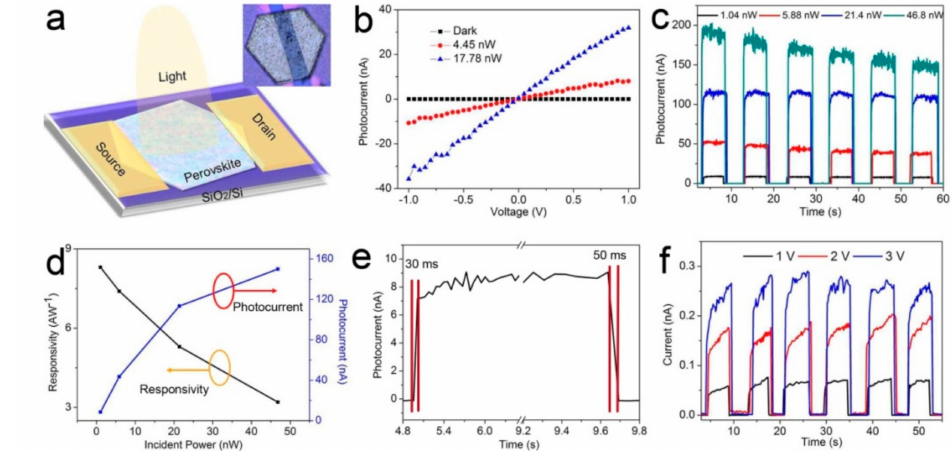
Figure 4. ( a ) Schematic of a 2D CH 3 NH 3 PbI 3 platelet phototransistor. The upright inset shows